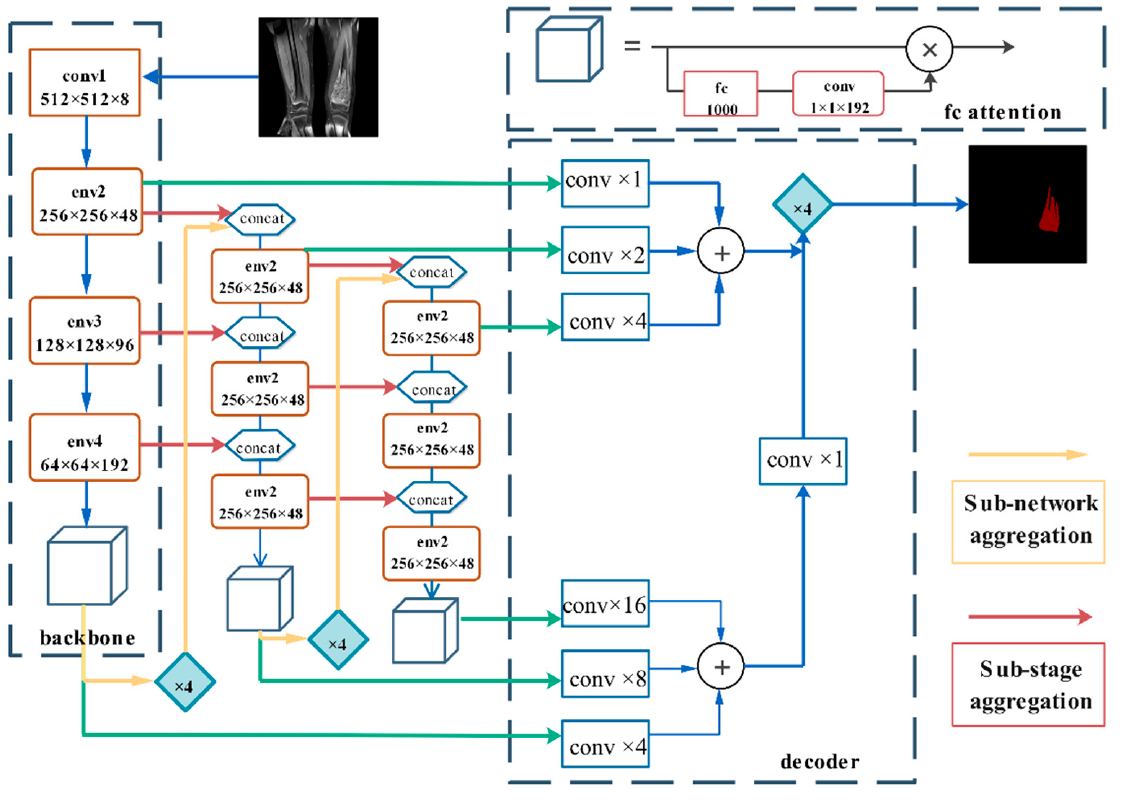
Figure 6. DFANet structure diagram.